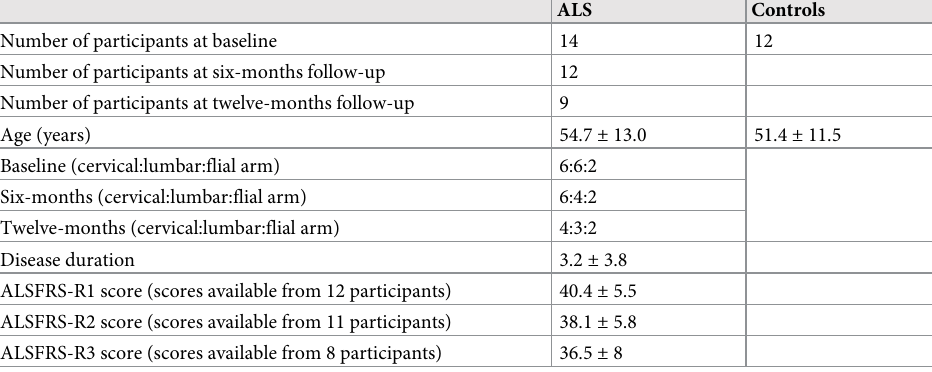
Table 1. Participant demographics. Disease duration based on patient report of symptom onset to time of baseline